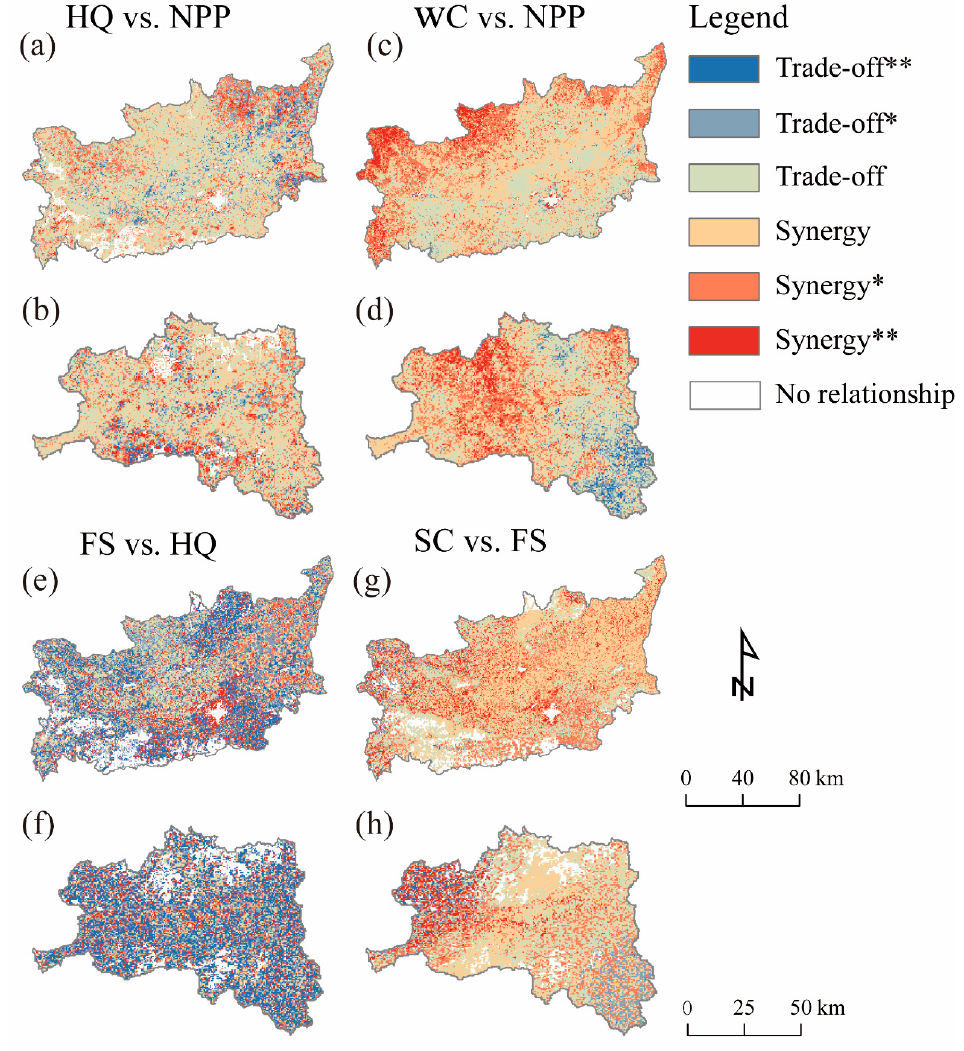
Figure 5. Spatial trade-offs and synergies of paired ecosystem services in two valley basins. ** Correlation were all significant at the 0.01 level. * Correlation were all significant at the 0.05level. ( a , b) : Spatial trade-offs and synergies for HQ(habitat quality) and NPP(net primary production) in Guanzhong and Hanzhong Basin, respectively. ( c , d) : Spatial trade-offs and synergies for WC(water conservation) and NPP. ( e , f) : Spatial trade-offs and synergies for FS(food supply) and HQ. ( g , h) : Spatial trade-offs and synergies for FS and SC(soil conservation).